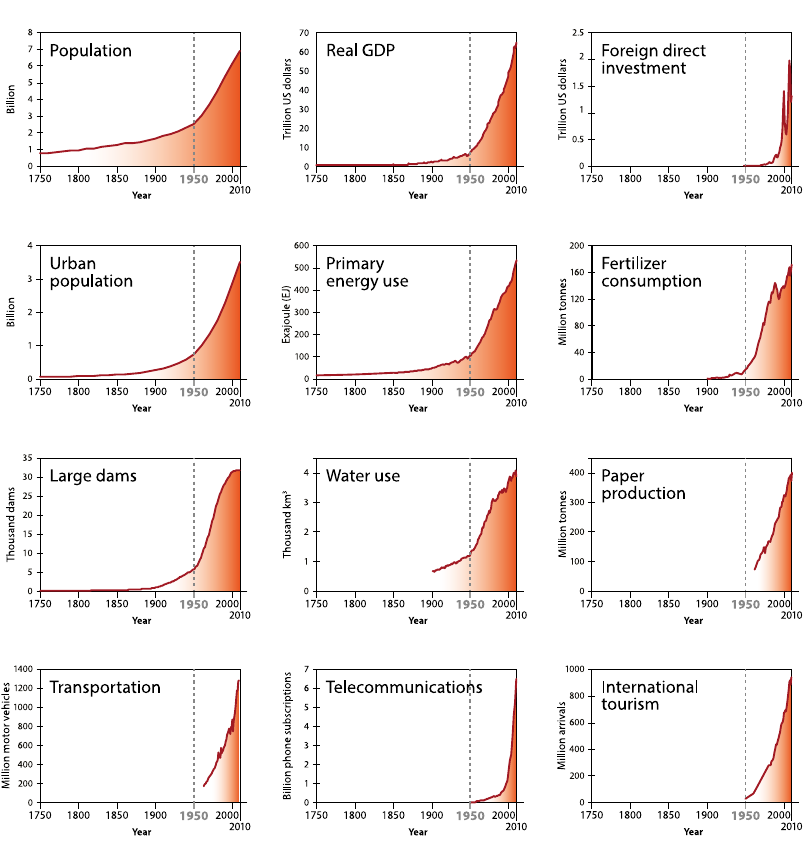
Figure 1. The Great Acceleration, social and economic aspects, courtesy Will